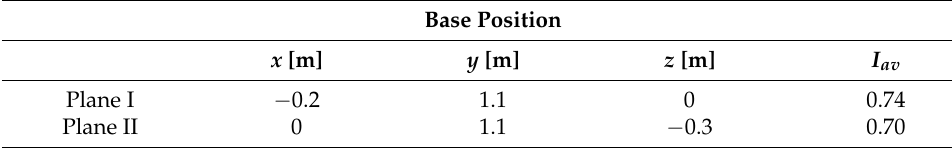
Table 5. Output of the global optimization.